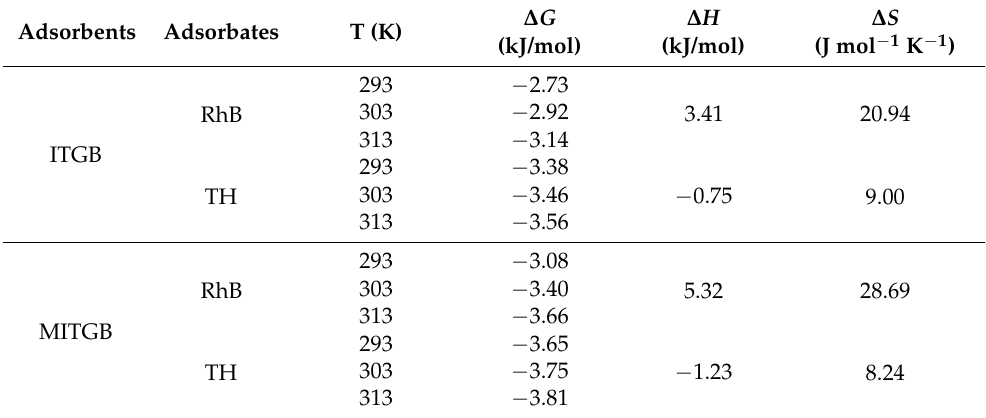
Table 4. Fitting adsorption thermodynamic parameters for RhB and